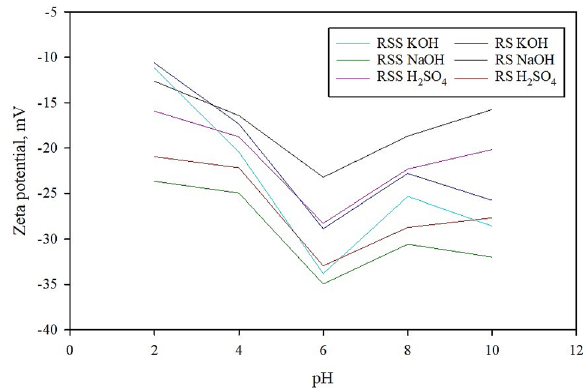
Figure 6. Zeta potential of the PAC adsorbent at various pH values.